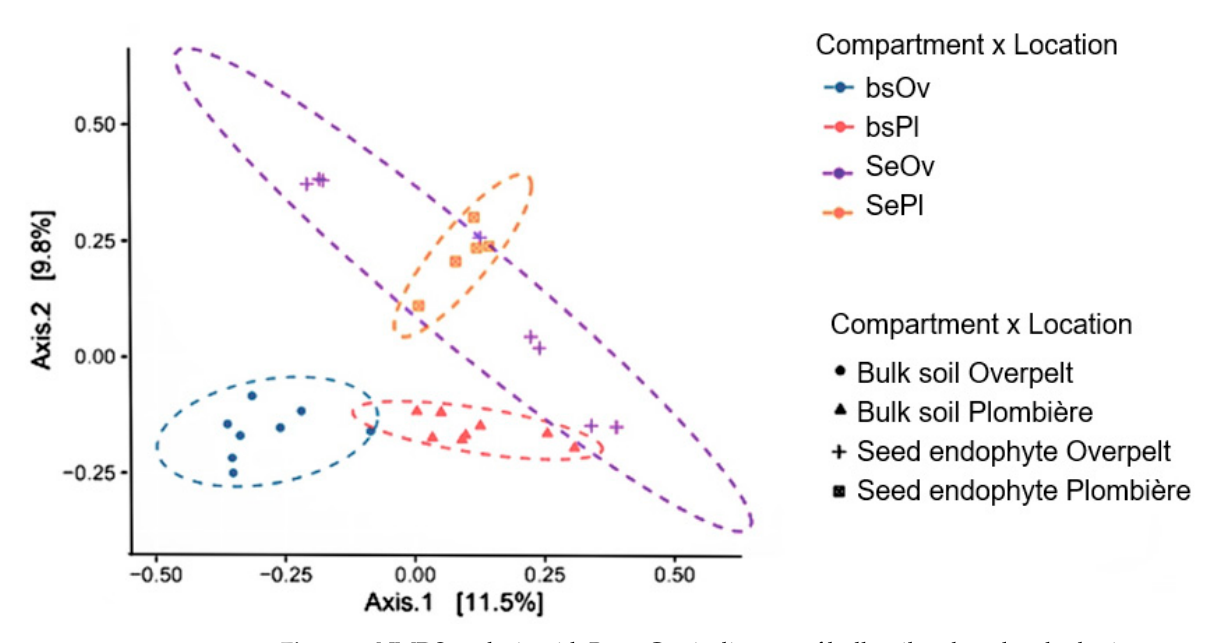
Figure 3. NMDS analysis with Bray–Curtis distance of bulk soil and seed endophytic communities from Overpelt and Plombières, Belgium.